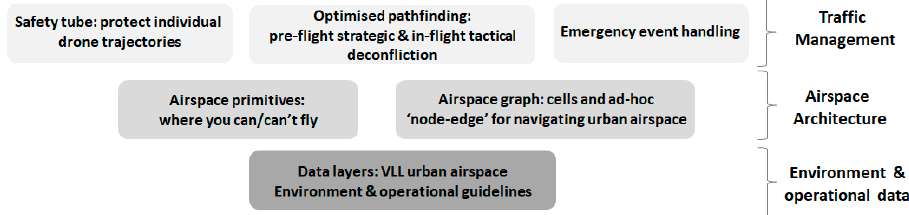
Figure 3. Schematic of three overarching urban UTM-related research challenges and associated topics addressed in this paper.